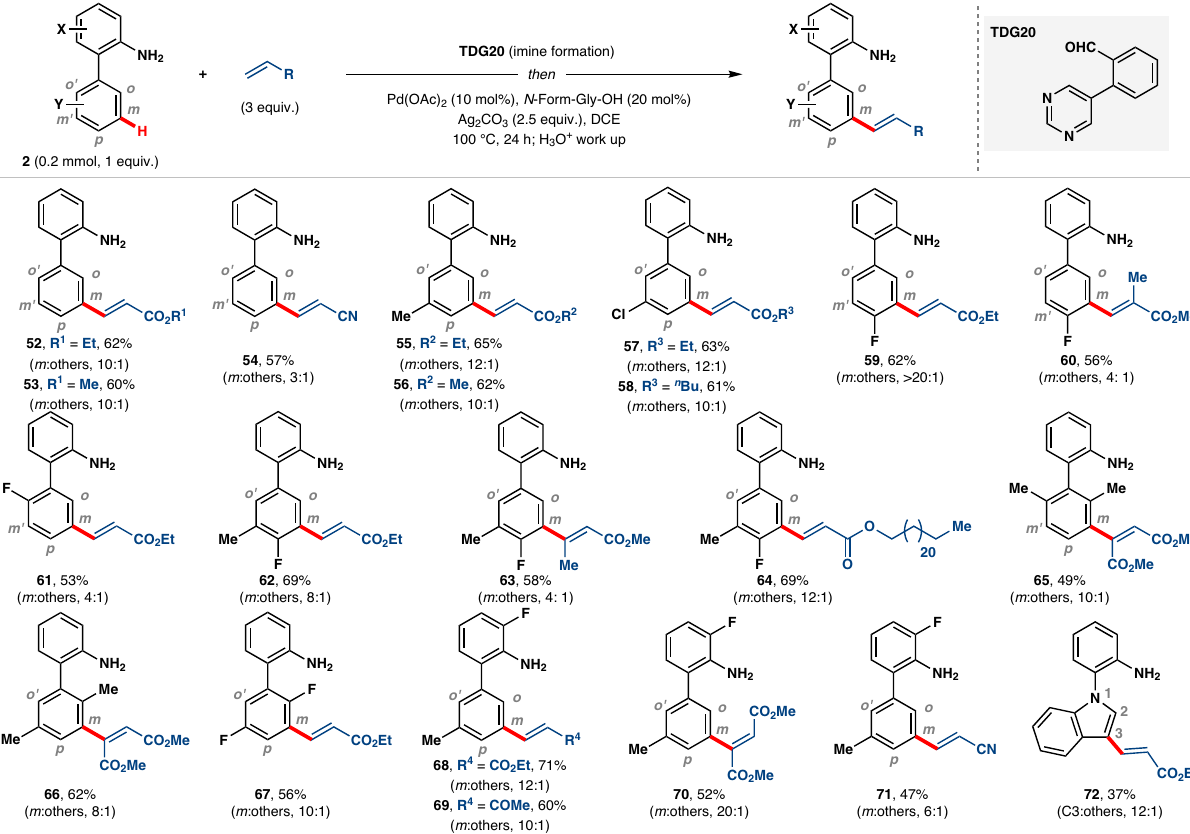
Fig. 5 Biphenyl amine substrates for selective meta -C – H functionalization. The isolated yields are reported and ratios of meta :others are shown in